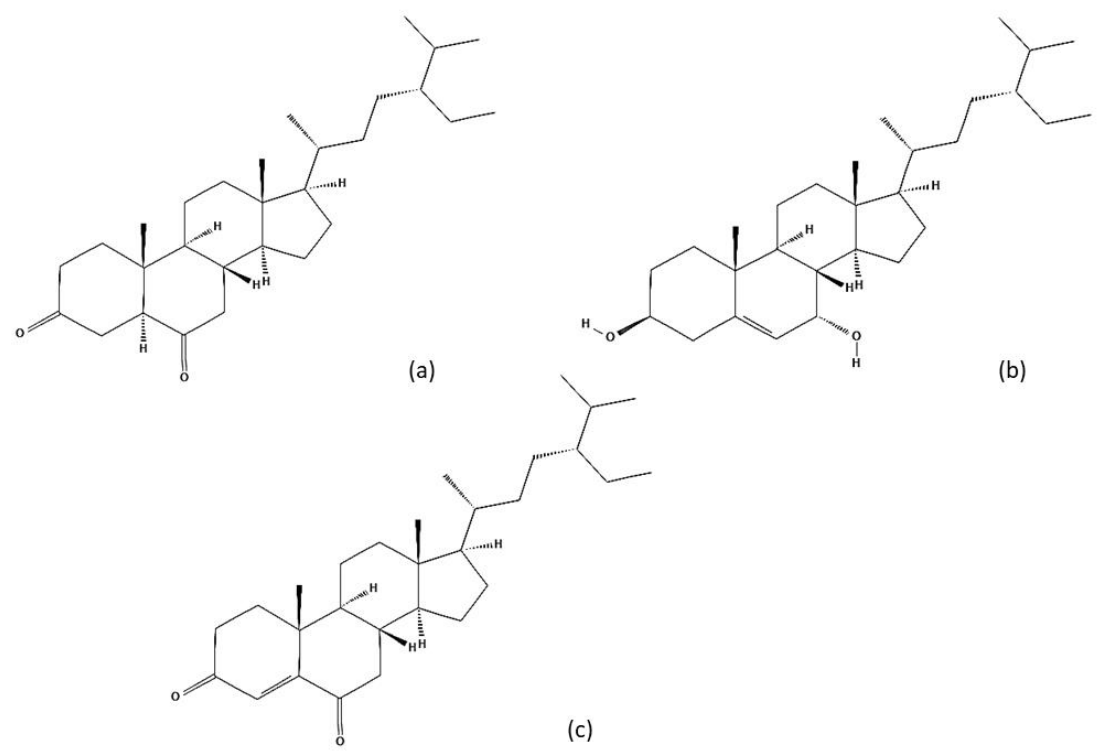
Figure 4. Some examples of steroids identified in A. altissima : ( a ) 5α-Stigmastane-3,6-dione; ( b ) Stigmast-5-ene-3β,7α-diol; ( c ) Stigmast-4-ene-3,6-dione.